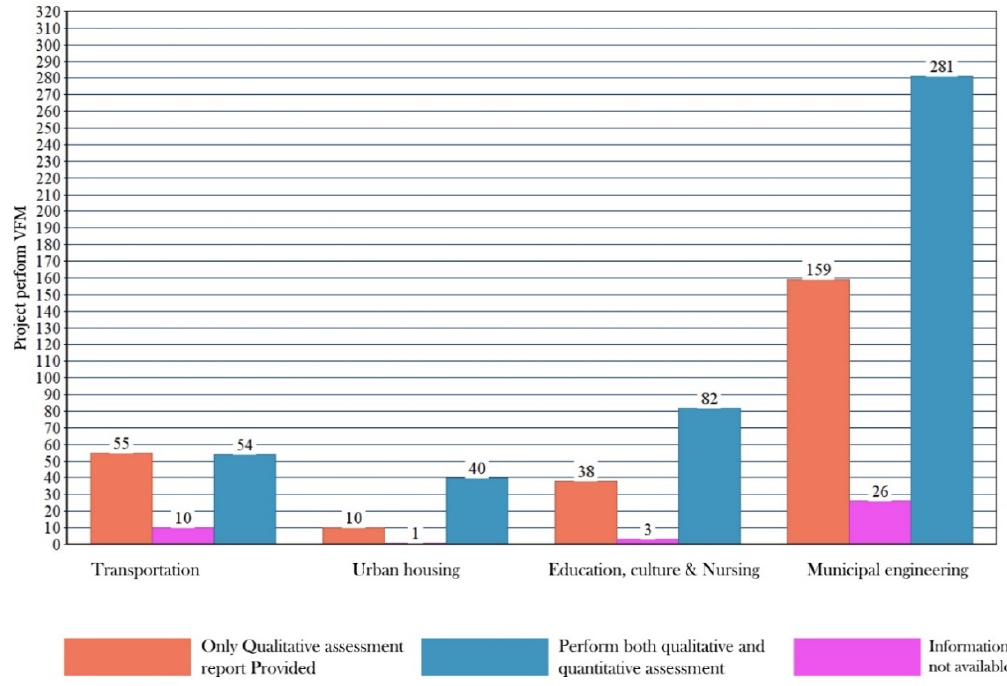
Figure 3. Value for money (VfM) implementation status in China. Source: published PPP project documents from the Ministry of Finance of China.